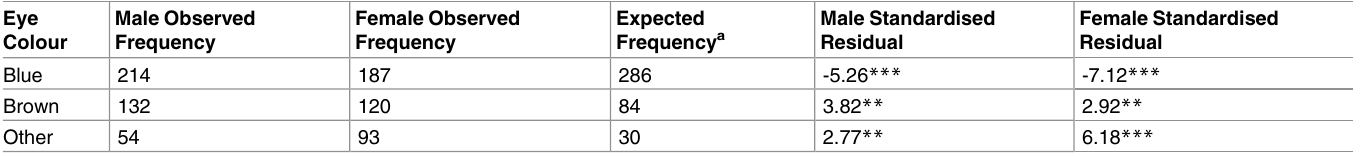
Table 1. Observed and expected eye colour frequencies in United Kingdom registeredcommercialmodels plus standardised residuals of a chi- square analysis for each sex. Eye Male Observed Colour